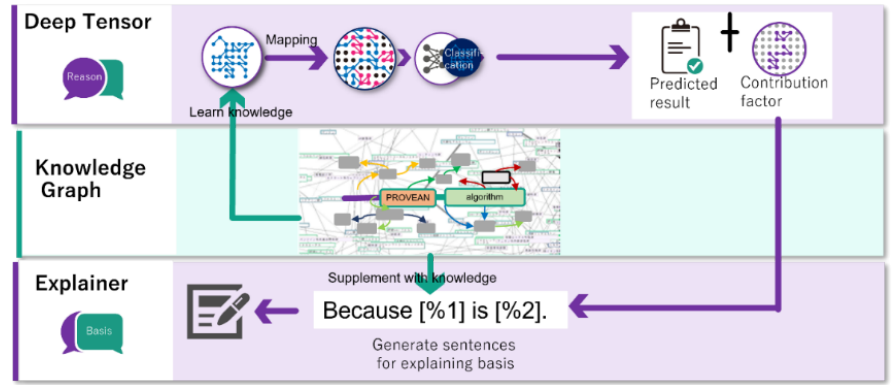
Figure 1. This is an overview of our explainable AI methodology using the knowledge graph and deep tensor.